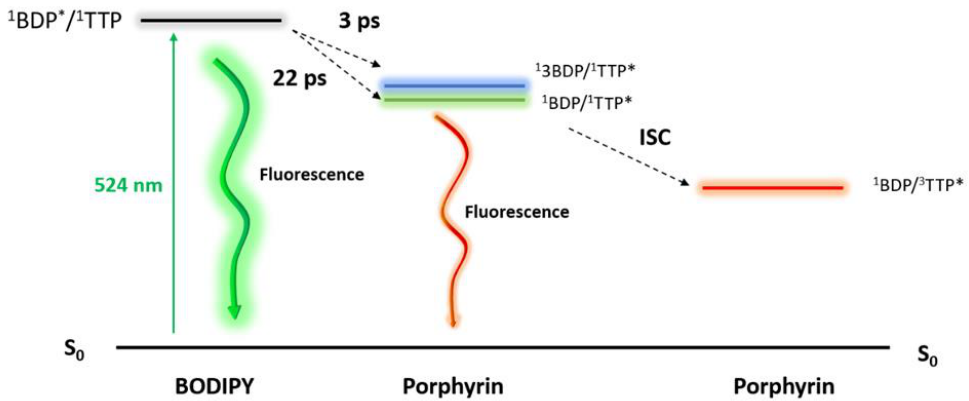
Figure 7. ( a )Decay kinetics of BDP –– TTP and 3BDP –– TTP at 524 nm probe wavelength. ( b )The inset represents zoomed decay traces between a 0 and 16 ps timescale.